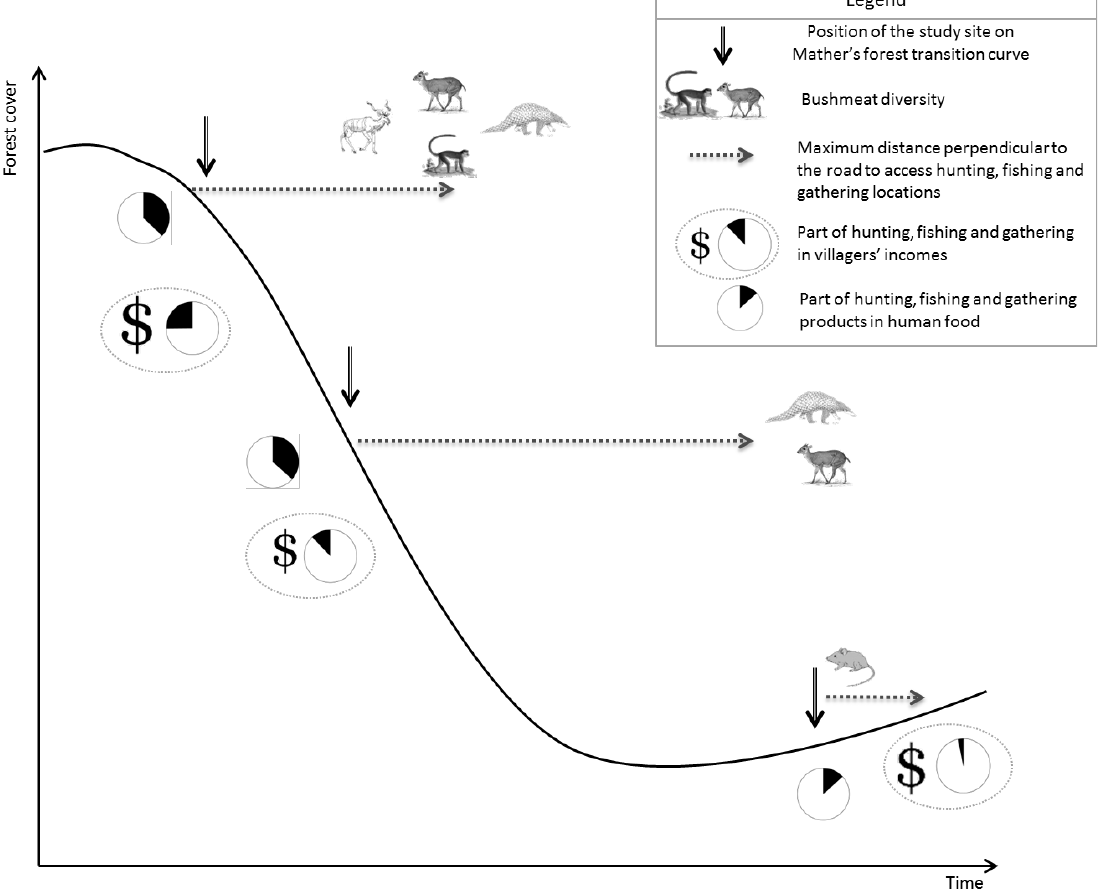
Figure 3. Illustration of the results: evolution of bushmeat diversity, maximal sampling distance, proportion of NTFP and bushmeat harvesting reflected in the income and in the dietary intake, at different stages along the forest transition curve.